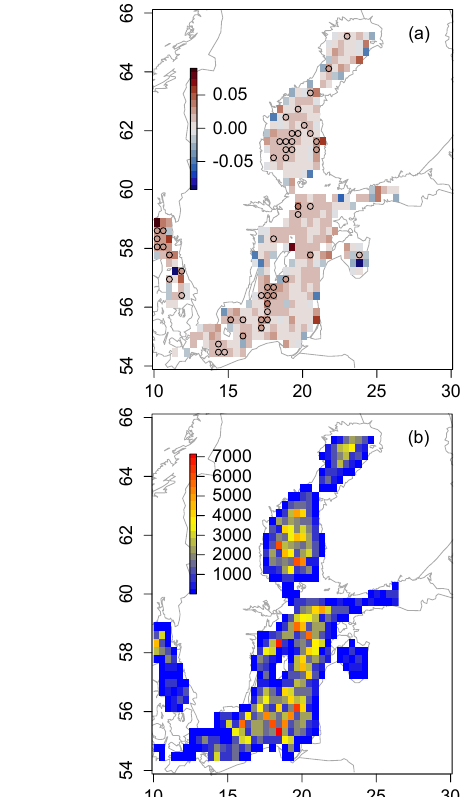
Figure 4. Spatial variability of wave climate in the Baltic Sea. (a) Slope (myr − 1 ; color scale) of linear trends in significant wave heights in the Baltic Sea in 1996–2015 from altimetry measure- ments (pixel size 0.4 × 0.3 ◦ ). Open circles indicate the pixels host- ing a statistically significant (at a >99% level) increase or decrease in the SWH. (b) Number of observations per pixel in 1996–2015 (pixel size 0.4 × 0.3 ◦ ). An increase in the pixel size compared to Fig. 2 (where the average SWH height is plotted using all available data over the whole period of observations) makes it possible to get a reasonable number of data points for each year for each particular pixel.